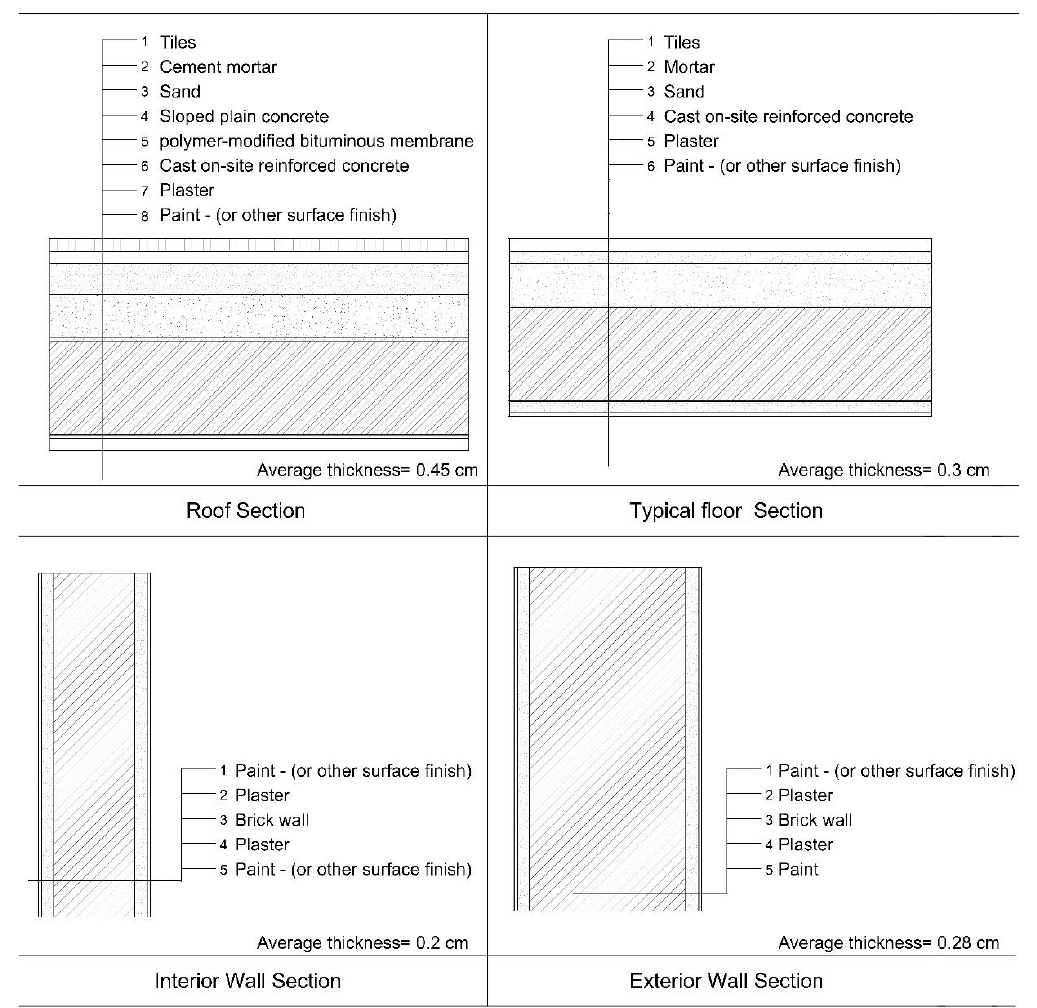
Figure 3. The typical sections for building components’ materials .